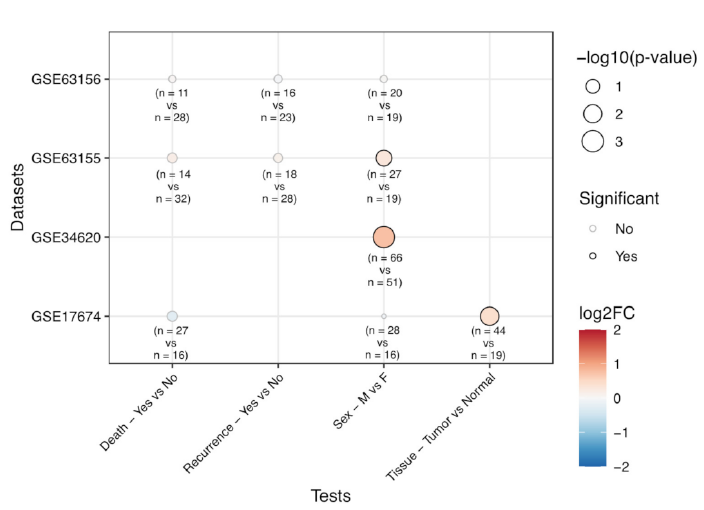
Figure 3. Bioinformatic analysis of EphA2 expression levels from public gene expression datasets on Ewing’s sarcoma samples, in relation to patient death status (sample sizes: Yes = 11, 14, 27; No = 28, 32 16, for GSE63156, GSE63155 and GSE17674 datasets, respectively), disease recurrence (sample sizes: Yes = 16, 18, No = 23, 28, for GSE63156 and GSE63155 datasets), sex (sample sizes: Male = 20, 27, 66, 28; Female = 19, 19, 51, 16, for GSE63156, GSE63155, GSE34620 and GSE17674 datasets, respectively) and tissue (sample sizes: Tumor= 44; Normal= 19, for GSE17674 dataset). The size of the dots is proportional to the significance of the statistical tests, while the color scale represents the log2 Fold Change (FC) of expression between the compared groups. Dots with a black border represent tests associated with a p -value lower than 0.05.